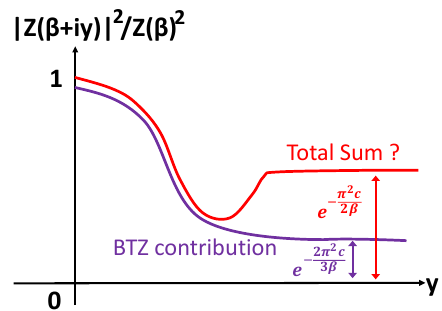
in the high temperature Z ( (cid:12) ) 2